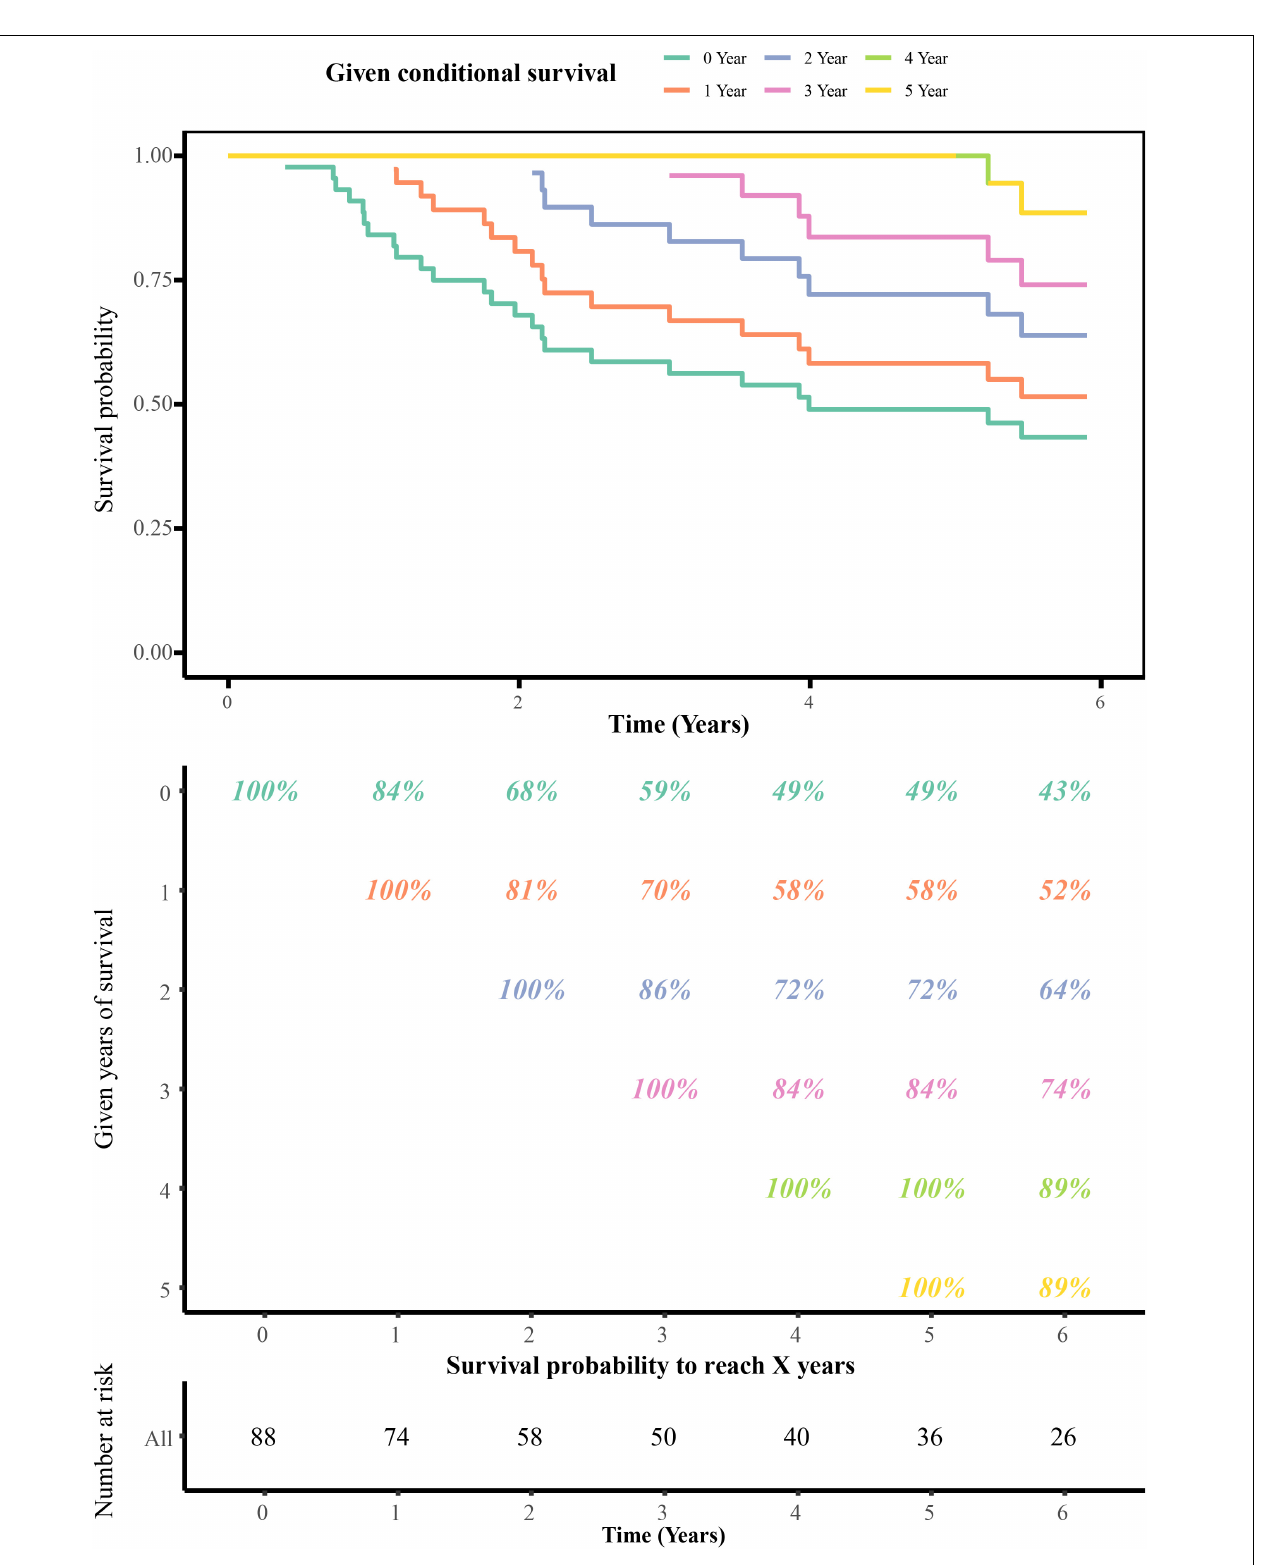
Frontiers in Cell and Developmental Biology |